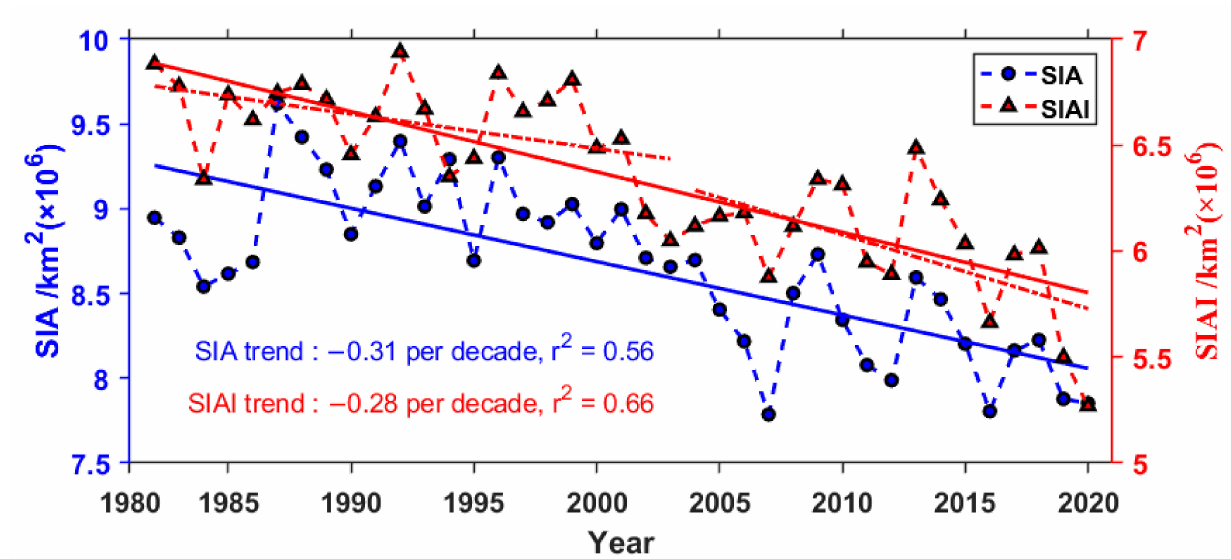
Figure 1. Long-term trends of sea ice area (SIA) and sea ice albedo index (SIAI) during March to September in the Arctic. The correlation coefficient is also shown.